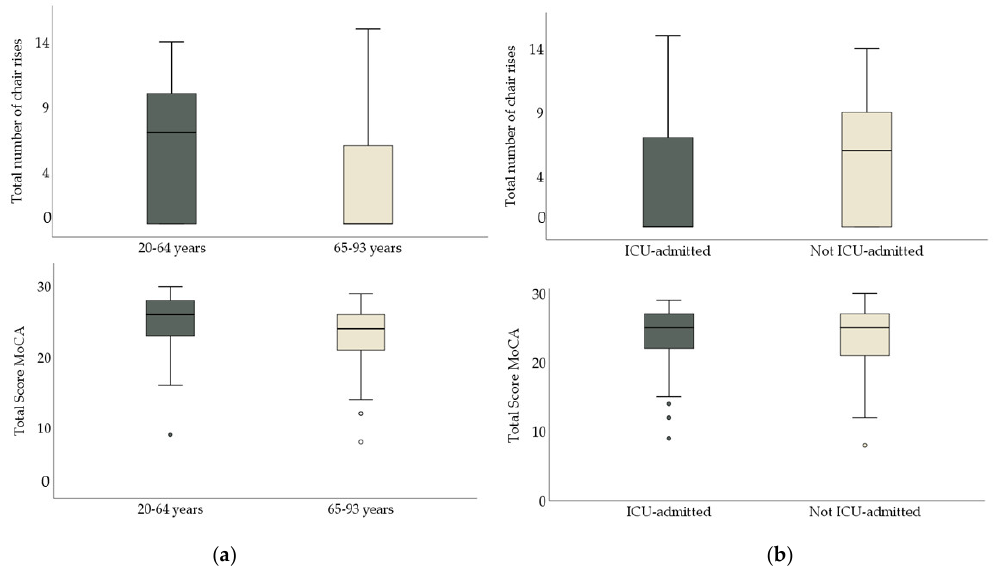
Figure 1. ( a ) To the left: total number of chair rises and total scare of Montreal Cognitive Assessment Scale (MoCA), depending on age group. ( b ) To the right: total number of chair rises and total score of MoCa depending on ICU–care.